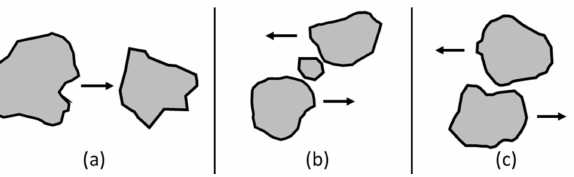
Figure 1. Grinding mechanisms: ( a ) compression, ( b ) chipping, ( c ) abrasion (adapted from Wills and Finch 2015 [27]).